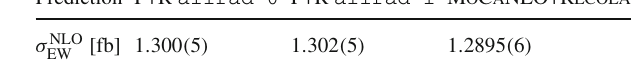
Table 2 Cross sections at NLO EW [order O μ + ν μ e + ν e jj at the 13TeV LHC. These have been obtained with Powheg+Recola (this work, abbreviated P+R ) with the flag allrad off/on and MoCaNLO+Recola (Ref. [7]). The digits in parenthesis indicate the integration error Prediction P+R allrad 0 P+R allrad 1 MoCaNLO+Recola